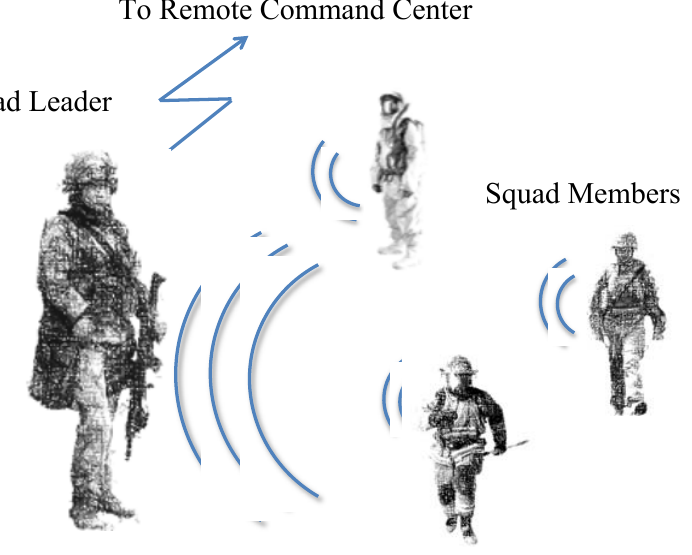
Figure 1. System overview of the full system to be implemented during the ATREC project, which integrates sensorized garments, wireless communication and wearable computing for a real-time assessment. Note that this paper will be focused on the textile-integrated measurement instrumentation portion of the